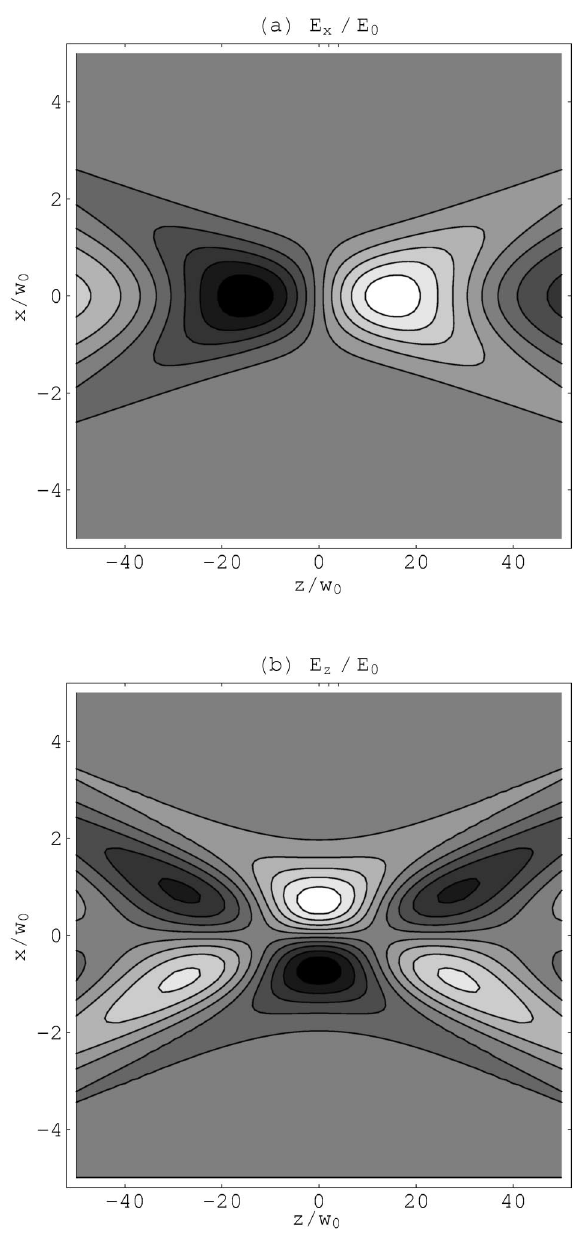
and E components over part x z